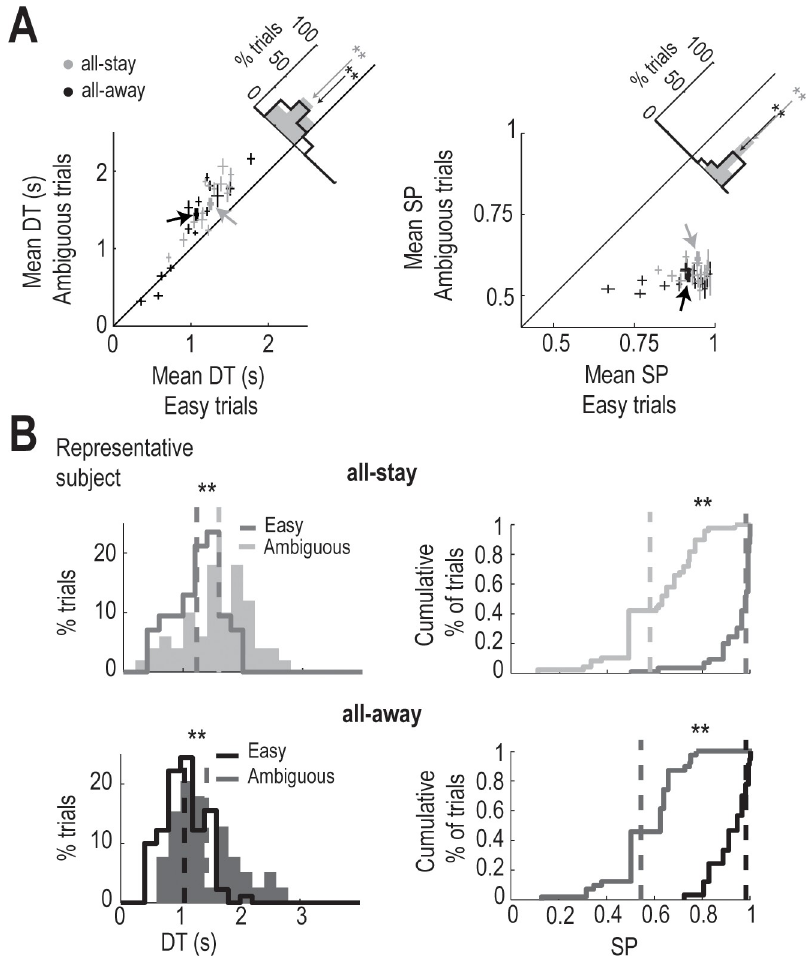
Fig 2. Behavior of subjects during easy and ambiguous trials. (A) Left panel , individual mean decision times (DTs) observed during easy and ambiguous trials for all-stay (gray) and all-away (black) conditions. Inset panel shows a histogram with the difference in DTs between trial types within each condition. The DTs for easy and ambiguous trials were significantly different in both conditions (n = 15; paired-samples t -test, �� p < 0.001; all-stay, p = 0.000003, t = 7.48; all-away, p = 0.0007, t = 4.32). Right panel , success probability (SP) at decision time for easy and ambiguous trials. Inset panel shows a histogram with the difference in SPs for the two trial types within each condition. The difference is significant for both conditions (n = 15; paired-samples t -test, �� p < 10 − 8 ; all-stay, p = 0.4 × 10 − 12 , t = 25.58; all-away, p = 0.2 × 10 − 9 , t = 16.38). Error bars indicate SEM. (B) DTs ( left panels ) and SPs ( right panels ) of a representative subject, whose mean DT and SP values are indicated by arrows in (A). The subject clearly shows the same behavioral effect as was observed for the group: faster DT and higher SP at decision time for easy trials than for ambiguous trials in both all-stay and all-away conditions (Kolmogorov–Smirnov test, �� p < 0.01; n easy = 52, n ambiguous = 37, all-stay: DTs, p = 0.00005, D = 0.4; SPs, p = 0, D = 0.89; n easy = 28, n ambiguous = 22, all-away: DTs, p = 0.002, D = 0.35; p = 0, D =